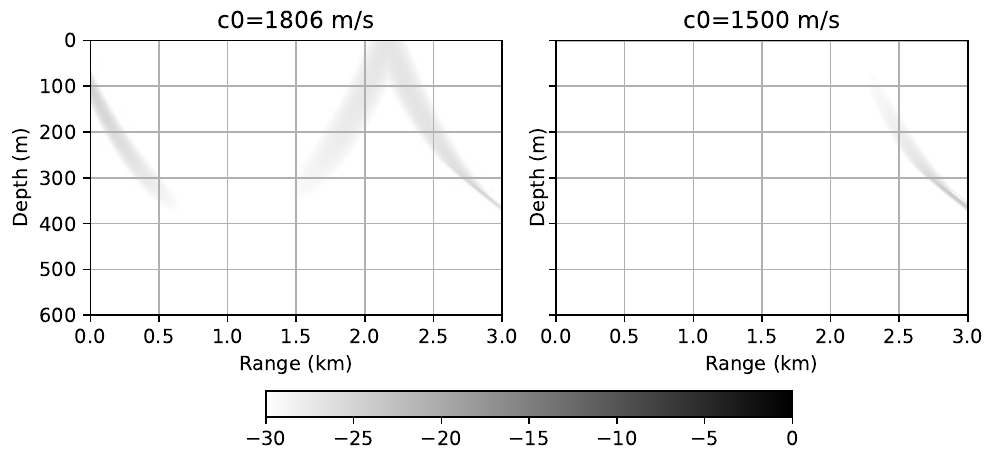
Figure 6. Waveguide with an inhomogeneous refractive index. Error distribution between the Padé approximation method and the WNI method (10log | ψ Pade − ψ WNI | ). ∆ x = 6 m, ∆ z = 0.07 m, c 0 = 1806 m/s ( left ) and ∆ x = 0.9 m, ∆ z = 0.06 m, c 0 = 1500 m/s ( right